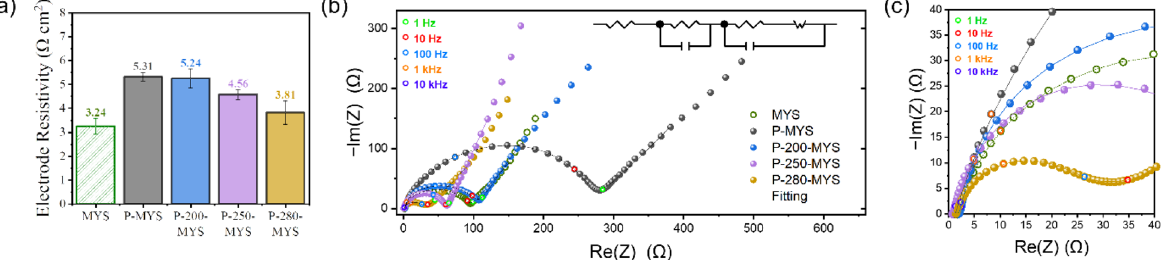
Fig. 3 a Resistivity of the as‑prepared multi‑yolk–shell (MYS)‑CuO cathodes with non‑cyclized PAN (P‑MYS; CuO: KB: PAN: PTFE cyclized at 200, 250, and 280 °C (P‑200‑MYS, P‑250‑MYS, and P‑280‑MYS, respectively; CuO: KB: PAN: PTFE PTFE 6:2:2). b Nyquist plots of the symmetric cells featuring different cathodes after resting for 1 week. c High‑frequency region of the Nyquist = plots in